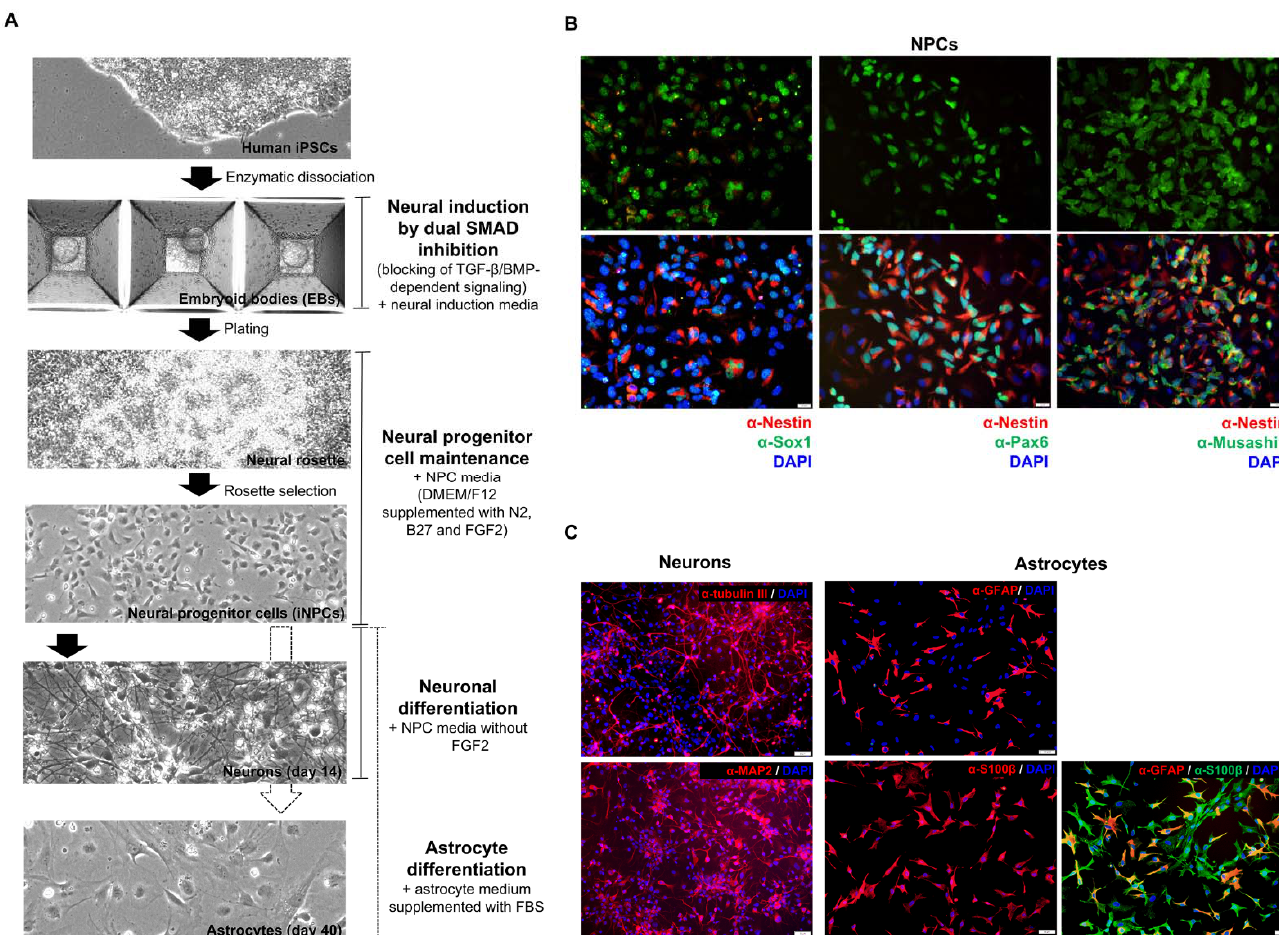
Figure 1. Generation and characterization of hiPSC-derived NPCs, neurons, and astrocytes and their expression of specific markers by IFA. ( A ) Schematic diagram summarizing the derivation of NPCs, neurons, and astrocytes from human iPSCs. ( B ) Undifferentiated NPCs were stained with mouse α -Nestin, rabbit α -Pax6, rabbit α -Musashi1, and rabbit α -Sox1 as primary antibodies. Goat α -mouse IgG Texas Red and goat α -rabbit IgG Alexa Fluor ® 488 were used as secondary antibodies. Scale bars = 20 µm. ( C ) Neurons were stained with mouse α - β -tubulin III and rabbit α -MAP2. Astrocytes were stained with mouse α -GFAP and rabbit α -S100 β as primary antibodies. Goat α -mouse IgG Texas Red, α -rabbit IgG TRITC and α -rabbit IgG Alexa Fluor ® 488 were used as the secondary antibodies. Scale bars = 50 µm.